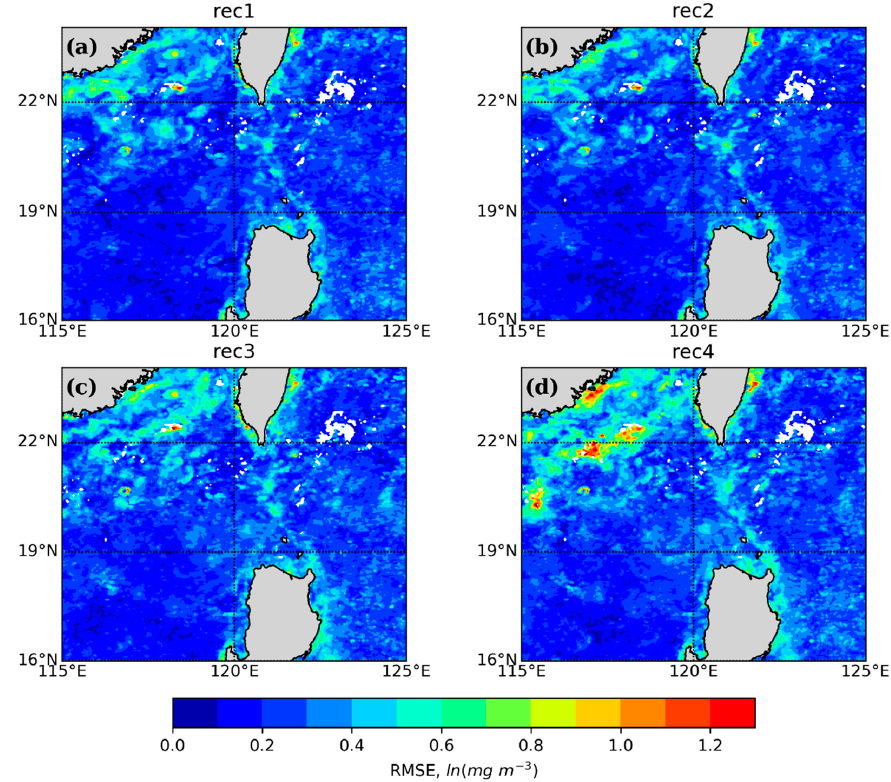
Figure 9. Spatial distribution of RMSE between cross-validation data and corresponding modeled data for the four reconstruction schemes: ( a ) rec1, ( b ) rec2, ( c ) rec3 and ( d ) rec4. Table 3. Relationship between Chl- a rec values and corresponding Chl- a sat values in SCS and WPS.